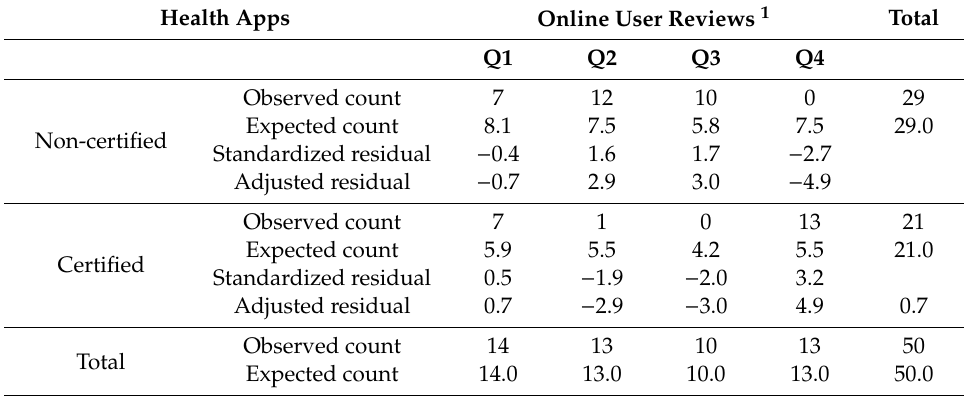
Table 4. Contingency table user reviews and quality seal.